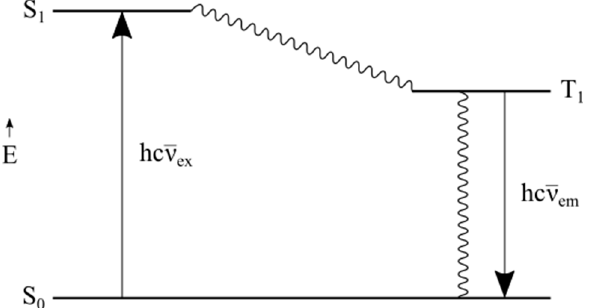
Figure 14. Simplified Jablonski diagram for a [Ru(phen) 3 ] 2+ or [Ru(bpy) 3 ] 2+ complex showing excitation, non-radiative decay pathways, and metal-to-ligand [20] charge-transfer phosphorescence (MLCT) T 1 → S 0 . The phosphorescence lifetime τ is temperature-dependent in these chromophores. Thus, they can be used for luminescence thermometry.